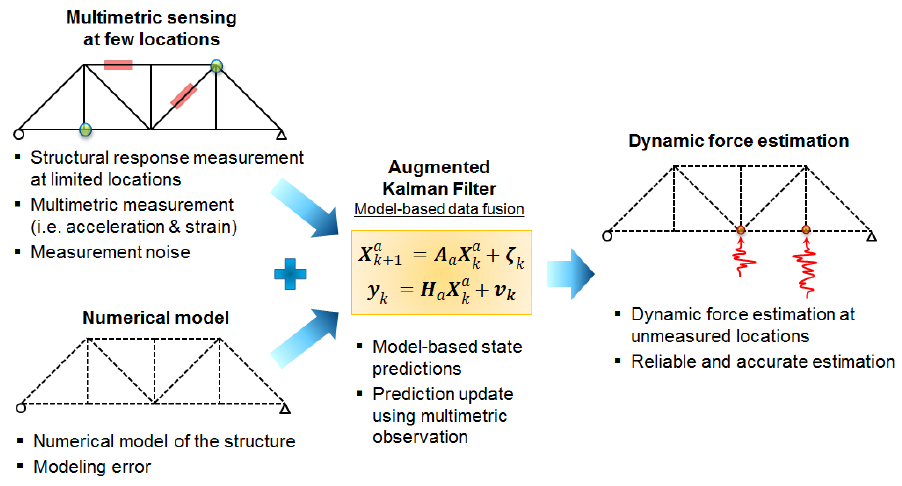
Figure 1. Schematic of proposed model-based heterogeneous data fusion for reliable force